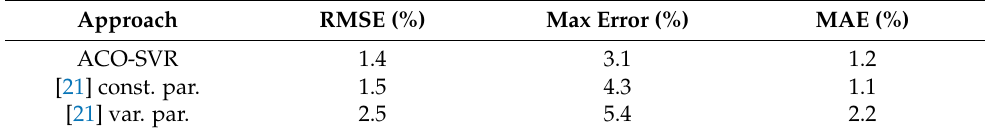
Table 5. Comparison of performance in SoC estimation through SVR approach, model-based ap- proach [21] with constant parameters, and the same approach [21] with SoC-varying parameters. Approach RMSE (%) Max Error (%) MAE (%) ACO-SVR 1.4 3.1 1.2 [21] const. par. [21] var. par.